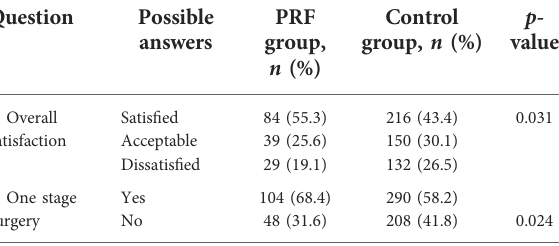
TABLE 2 Patients possible answers included in the